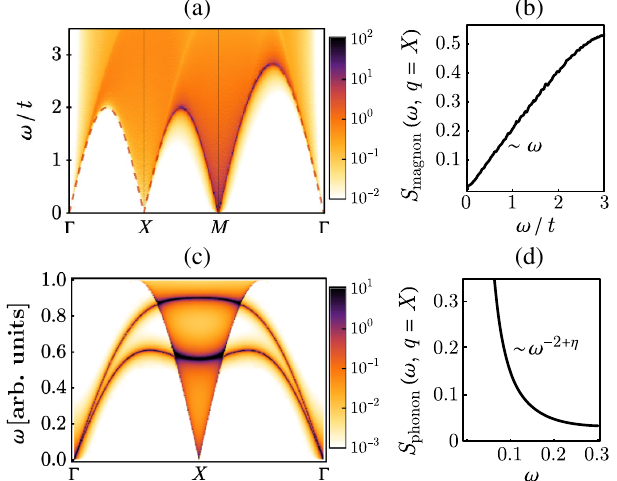
FIG. 11. (a) Spin excitation spectrum (dynamical structural ð ω ; q Þ at the DQCP. A darker color indicates a factor) S magnon higher intensity. The dashed line traces out the lower edge of the continuum which is described by Eq. (13). (b) The frequency dependence of the spectral intensity at the extinction point X . At the low-frequency limit, the spectral intensity grows with frequency linearly, which manifests the conserved current asso- ciated to the emergent O(4) symmetry. (c) Schematic illustration ð ω ; q Þ . The bare phonon of the phonon spectrum S phonon dispersion is inferred from Ref. [67]. The VBS-phonon coupling leads to a continuum in the phonon spectrum. (d) The frequency dependence of the phonon spectral intensity at the extinction point X . The intensity falls off in a power law with the frequency, whose exponent should be the same as that of the spin fluctuation at M point.